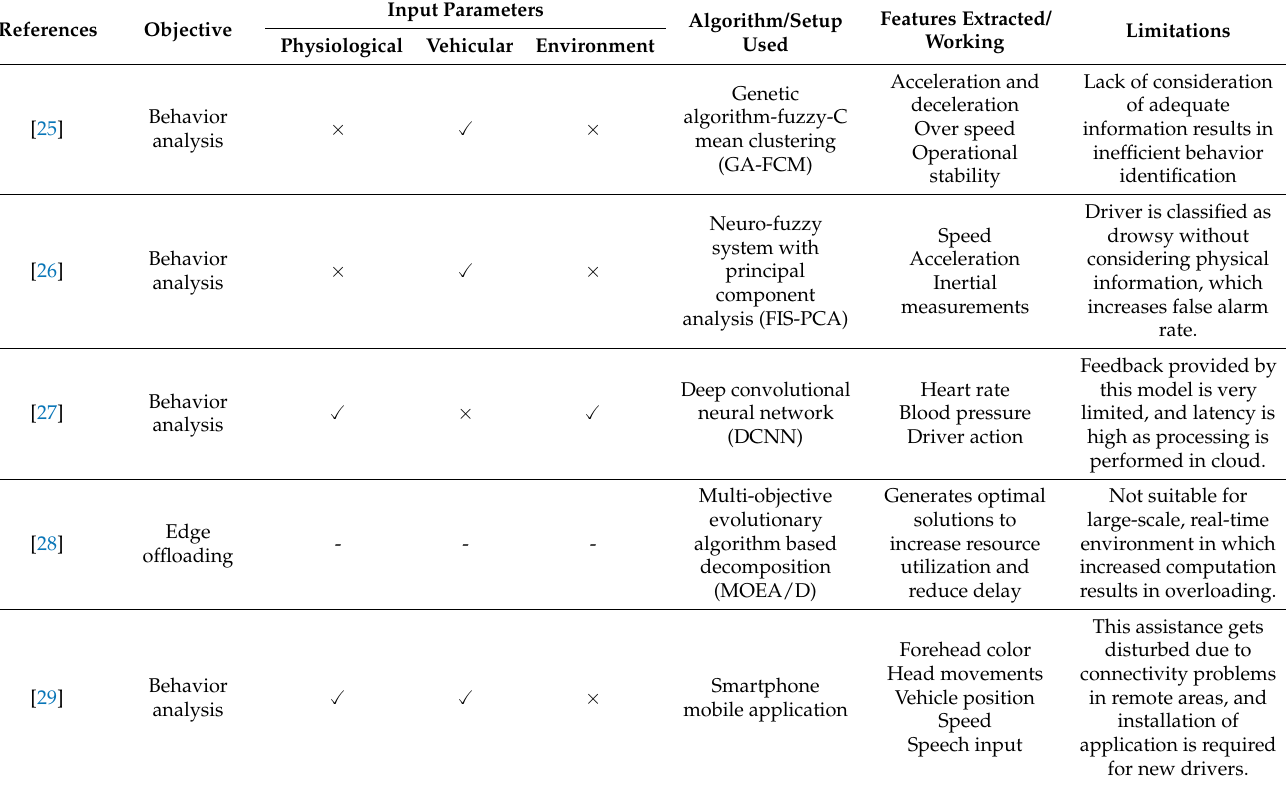
Table 1. Research Gaps in Previous